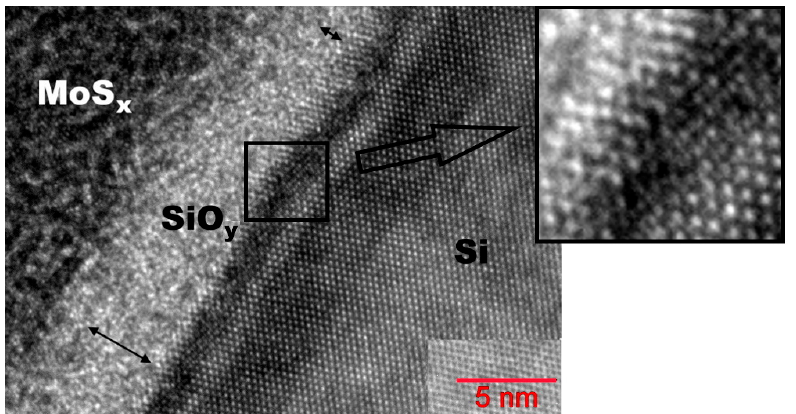
Figure 10. HRTEM image of an interface layer of a-MoS x /NP-Mo film with Si substrate subjected to pulsed laser P doping. The insert shows the nanocrystalline character of the laser-treated Si surface.